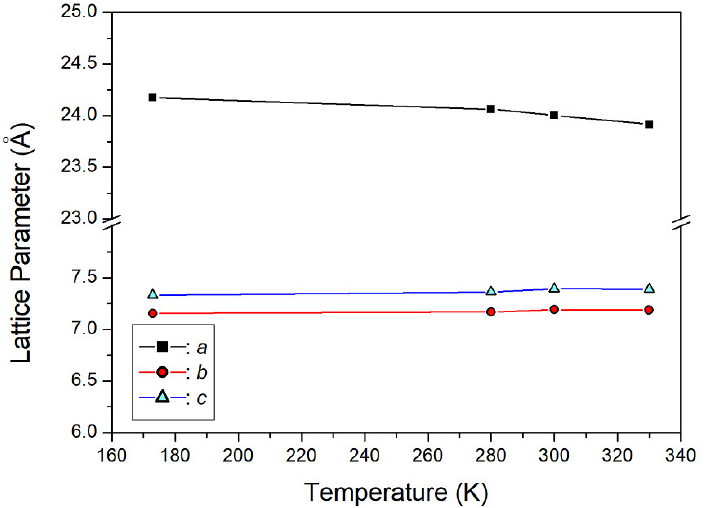
Figure 5. Single-crystal XRD parameters of a [NH 3 (CH 2 ) 5 NH 3 ]MnCl 4 crystal at 173, 280, 300, and 333 K.